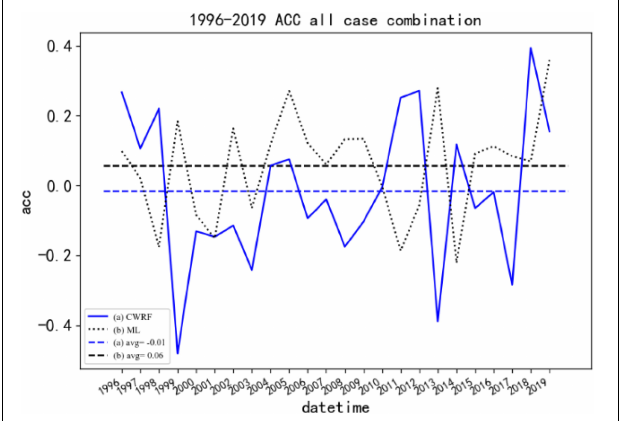
FIGURE 11 | Comparison of ACC before and after CWRF forecast correction for 7 case sets. (a) CWRF forecast, (b) machine learning correction, and (a, b) 1996–2019